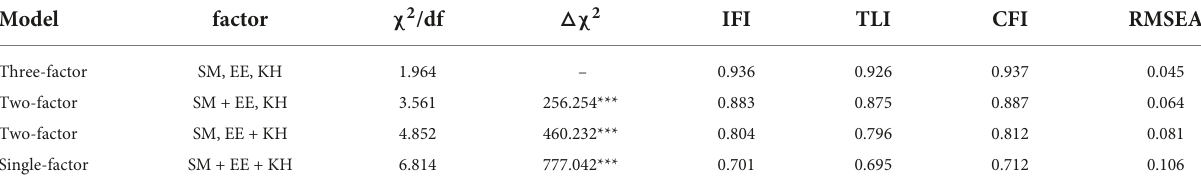
TABLE 2 Results of confirmatory factor